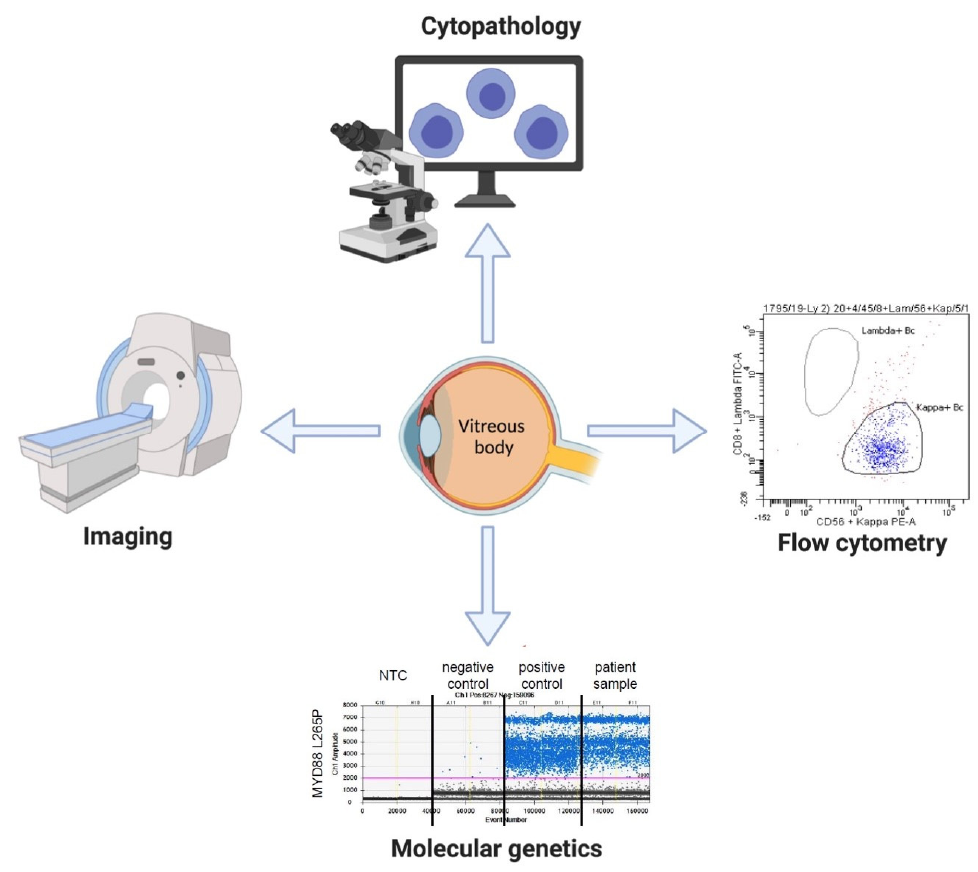
Figure 1. Diagnostic panel for intraocular lymphoma.